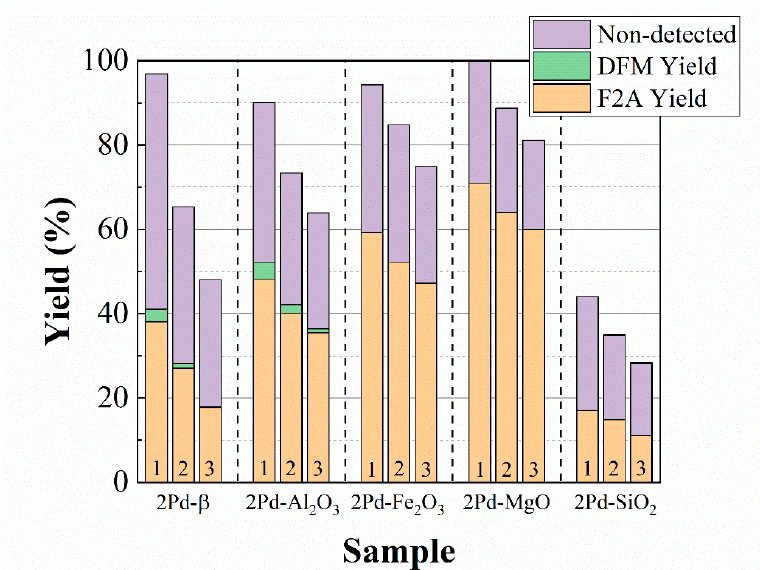
Figure 10. Reuse for Pd-based catalysts supported on β -zeolite, Al 2 O 3 , Fe 2 O 3 , MgO, and SiO 2 . Experimental conditions: temperature: 170 ◦ C, time: 3 h, catalyst loading: 0.05 g, V (ethanol) : 6 mL, amount of base (Na 2 CO 3 ): 0.10 g, V (H 2 O 2 , 30 wt%): 0.5 mL.